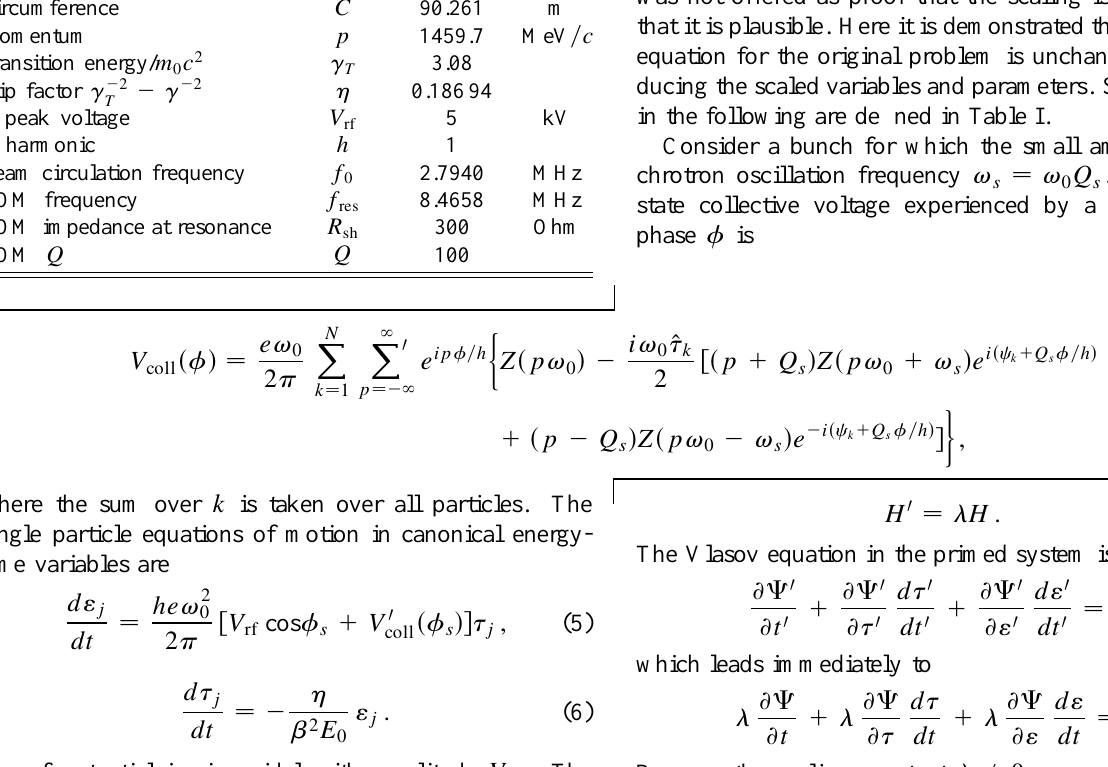
TABLE II. Storage ring parameters used in tracking examples. Parameter Symbol